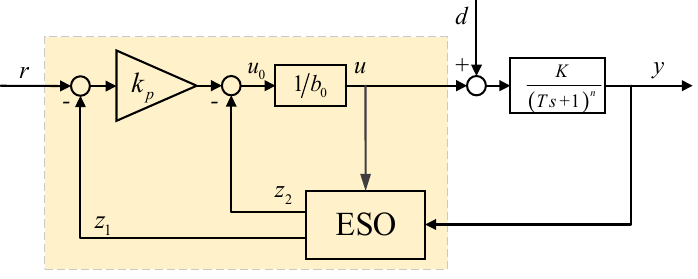
Figure 1. Schematic diagram of the first-order linear ADRC.